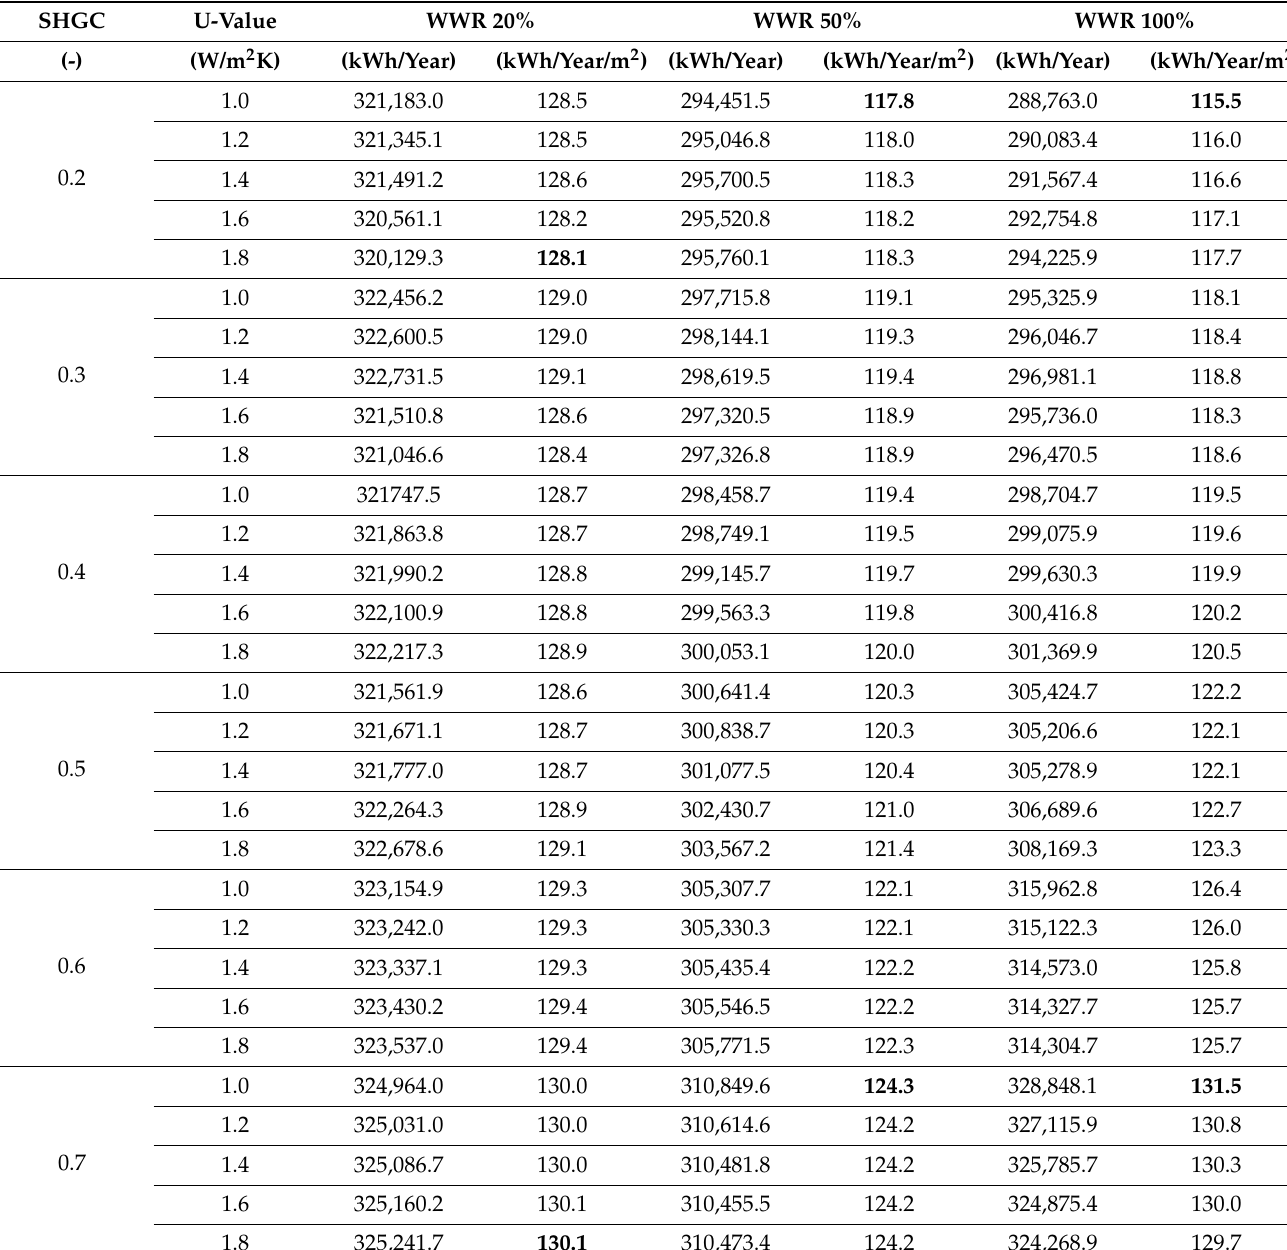
Table 6. Energy demands according to the window properties (visible light transmittance: